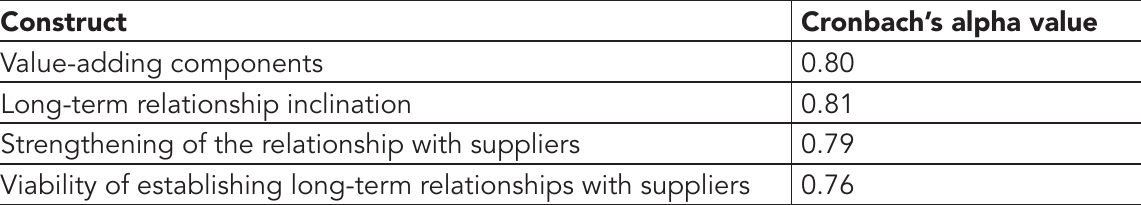
Table II: Cronbach’s alpha values for the supplier relationship